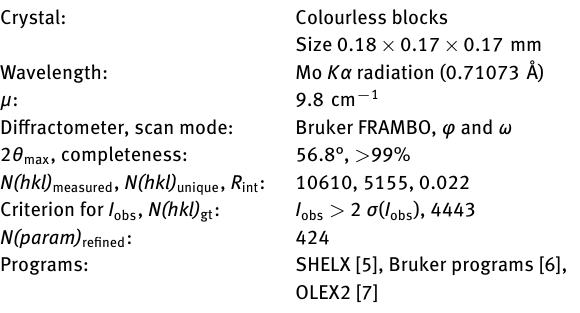
Table 1: Data collection and